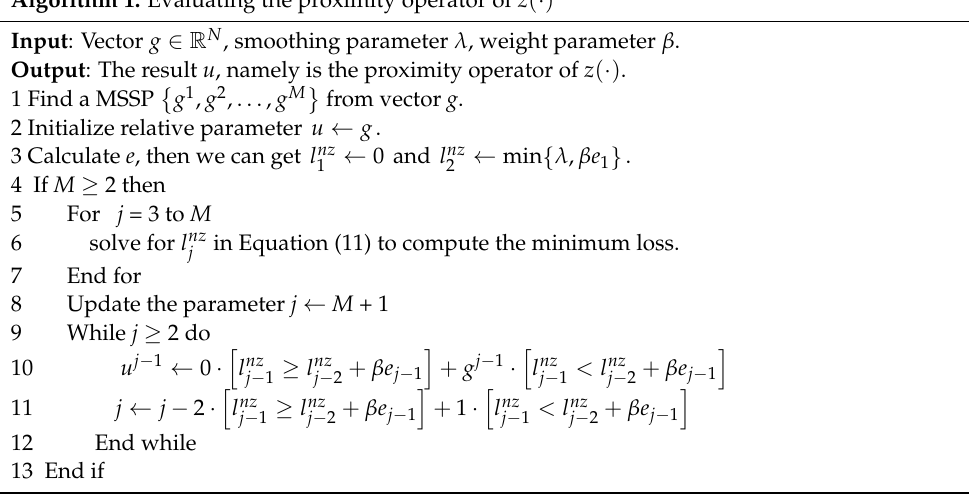
Algorithm 1 summarizes the process of using dynamic programming to solve Equation (8), using the form of filling from the bottom up. Algorithm 1. Evaluating the proximity operator of z ( ·